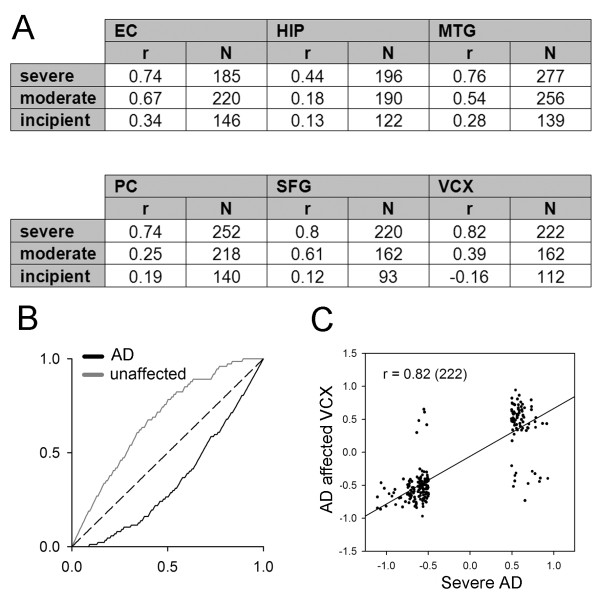
A severe AD query is highly correlated with another AD transcription profiling study in SPIED. The regression scores across six brain regions are shown in A. All apart from HIP are highly correlated with the severe AD profile. The overall enrichment for positive query correlation is shown in B (see Figure 4 legend for definition of enrichment plot) and a particular brain region regression plot is illustrated in C.